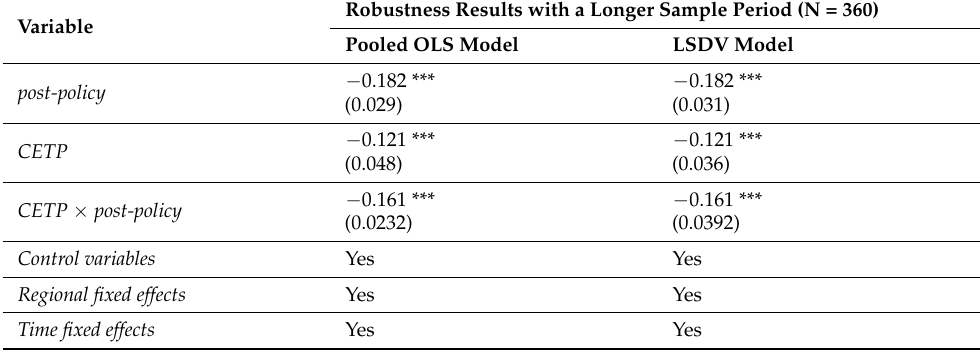
Table 5. Results of DID analysis using a longer sample period.